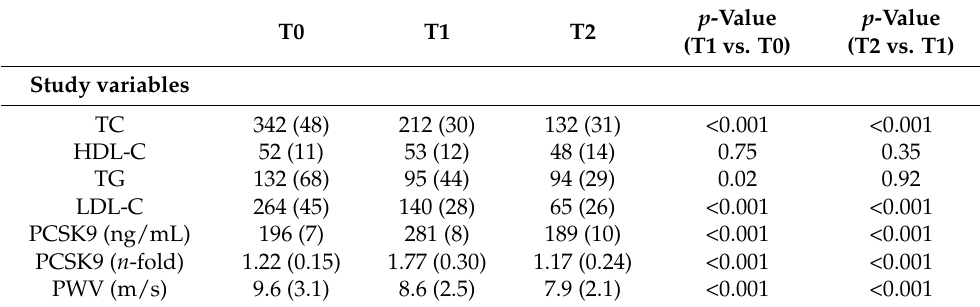
Table 2. Lipid parameters, PCSK9 and PWV change over time in